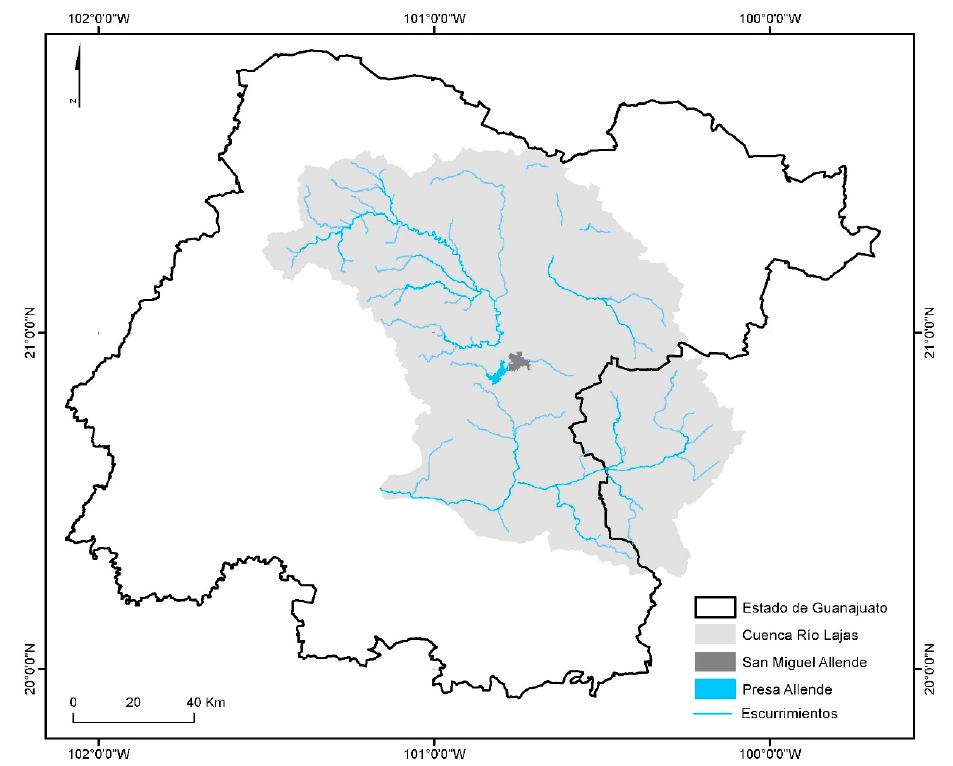
Figure 2. The R í o Laja watershed within the context of the state of Guanajuato. Source: Own Figure 2. The Río Laja watershed within the context of the state of Guanajuato. Source: Own construction (map drawn by Oscar construction (map drawn by Oscar Salvatore).